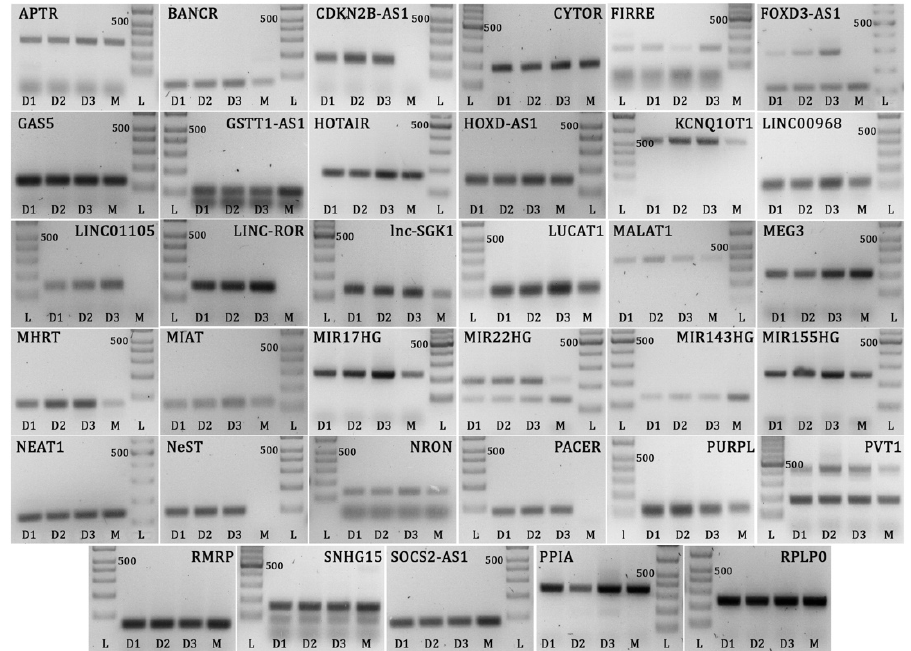
Figure 1. Gel images showing Müller cell long non-coding RNAs and reference gene amplicons run on 2% or 3% agarose gel. L = DNA ladder, D1 = human donor cell isolate 1, D2 = human donor cell isolate 2, D3 = human donor cell isolate 3, M = MIO-M1 cell line. Expected product sizes: APTR = 300